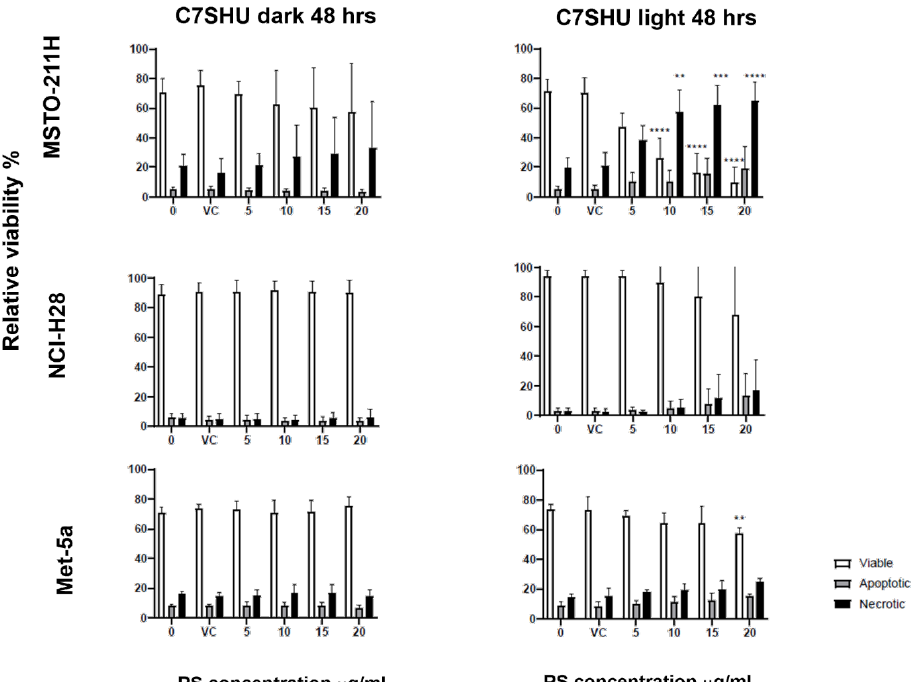
Figure 12. Cell death analysis of C7SHU-treated MSTO-211H, NCI-H28, and Met-5a cells as deter- mined by the Annexin V-FITC/PI assay 48 h after treatment. Results are expressed as the mean ± SD of three independent experiments. The varying significance of viable populations relative to that of the untreated control are indicated by * ( p ≤ 0.05), ** ( p ≤ 0.01), *** ( p ≤ 0.001), and **** ( p ≤ 0.0001). Table 1. Dose response, EC 50 values for PDT activity in the PS C5SHU, C6SHU, and C7SHU in the MSTO-211H, NCI-H28, and MET-5a cell lines at 24 and 48 h time points. EC 50 values are an average of three independent experiments, given in μg/mL and errors are included at ± SD.